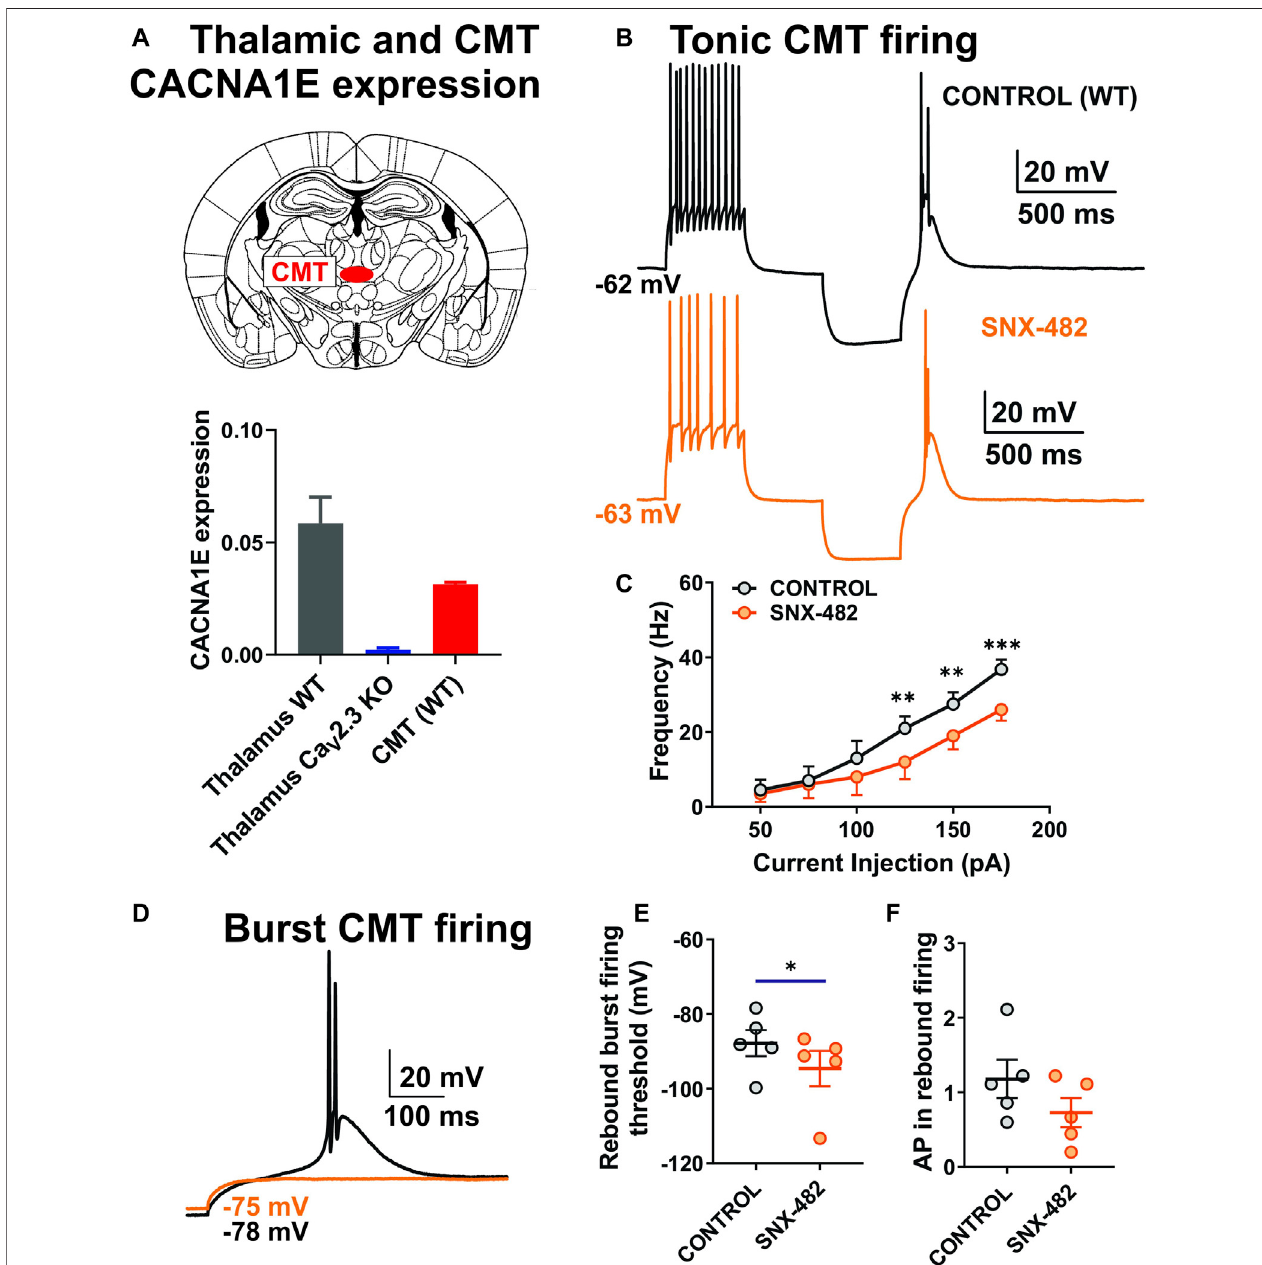
FIGURE 2 | Stimulated tonic and rebound burst fi ring was reduced in thalamic neurons during the application of SNX-482 in WT animals. (A) Schematic presentation of CMT and qPCR data from the whole thalamus (WT and Ca V 2.3 KO mice, N = 4 and 4, respectively) and CMT (WT animals, N = 3, technical replicate presented). (B) Representative traces of CMT action potential fi ring before (black) and during the application of 0.5 μ M of SNX-482 (orange) recorded at an RMP of − 60 mV. (C) Average frequency of stimulated tonic fi ring mode before and after the perfusion of SNX-482 ( n = 5, two-way RM ANOVA: interaction F 5,20 = 3.44, p = 0.021; SNX-482 F 1,4 = 7.46, p = 0.052; current injection F 5,20 = 40.73, p < 0.001, Š ídák ’ s multiple comparisons test presented). (D) Representative traces of rebound burst fi ring before (black) and during the application of SNX-482 (orange) in the same CMT neuron; note that with the same current injection, there is no rebound burst fi ring after SNX-482 perfusion. (E) Rebound burst fi ring threshold after the hyperpolarization of the CMT neurons before and during the application of SNX-482 ( n = 5, paired two-tailed t -test, t 4 = 3.49, p = 0.025). (F) Average numbers of AP in rebound burst fi ring in control and after SNX-482 ( n = 5, paired two-tailed t -test, t 4 = 2.265, p = 0.086). * p < 0.05, ** p < 0.01, *** p < 0.001.